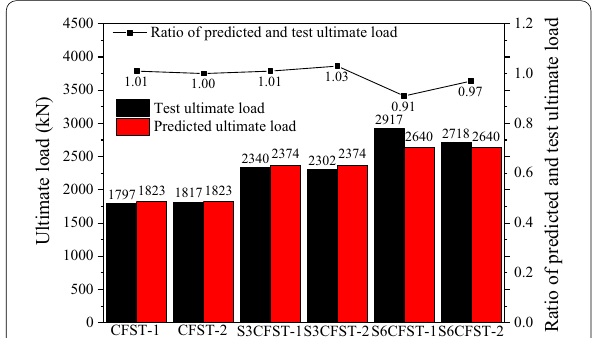
Fig. 17 Evaluation of the proposed